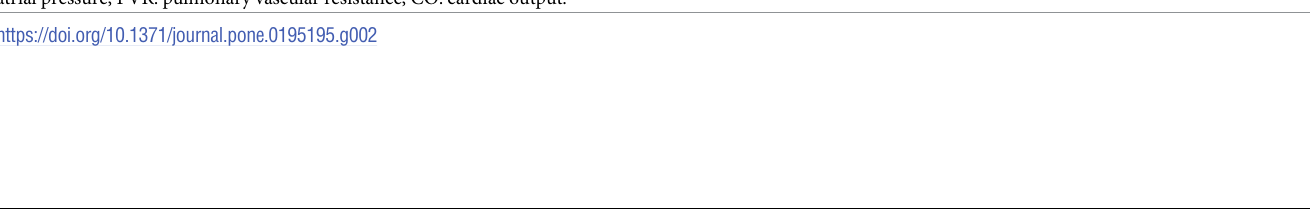
PLOS ONE | https://doi.org/10.1371/journal.pone.0195195 April 2,